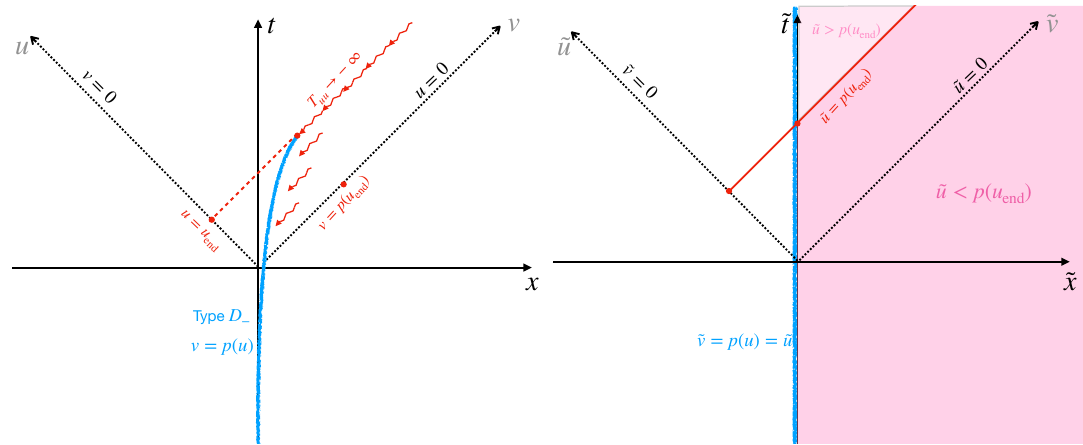
Figure 19 . Physical spacetime (pink shaded area) is divided by a null surface into two parts. Left: the null surface is located at u = u which generates infinite-energy flux along the null surface at its endpoint. Right: the physical region in (˜ t, ˜ x ) coordinates is the pink shaded region divided by the null surface at ˜ u = p ( u two